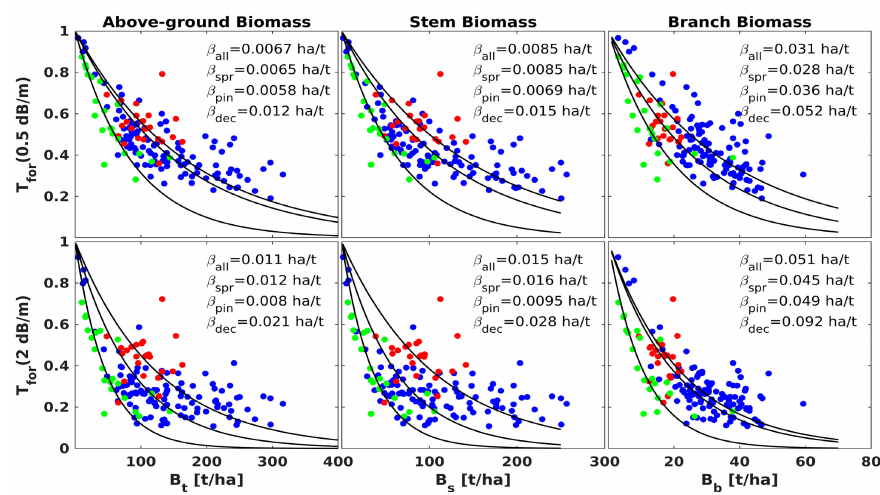
Figure 5. Simulated forest transmissivity for pine (red), spruce (blue), and deciduous (green) forests based on LiDAR-derived height and canopy cover as function of above-ground, stem, and branch